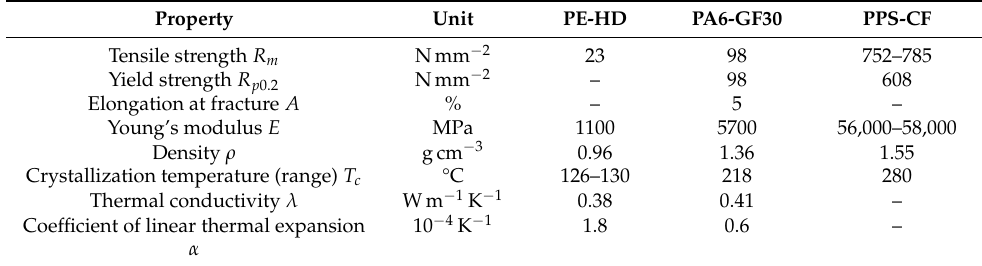
Table A3. Selected mechanical and thermal properties of the plastics used